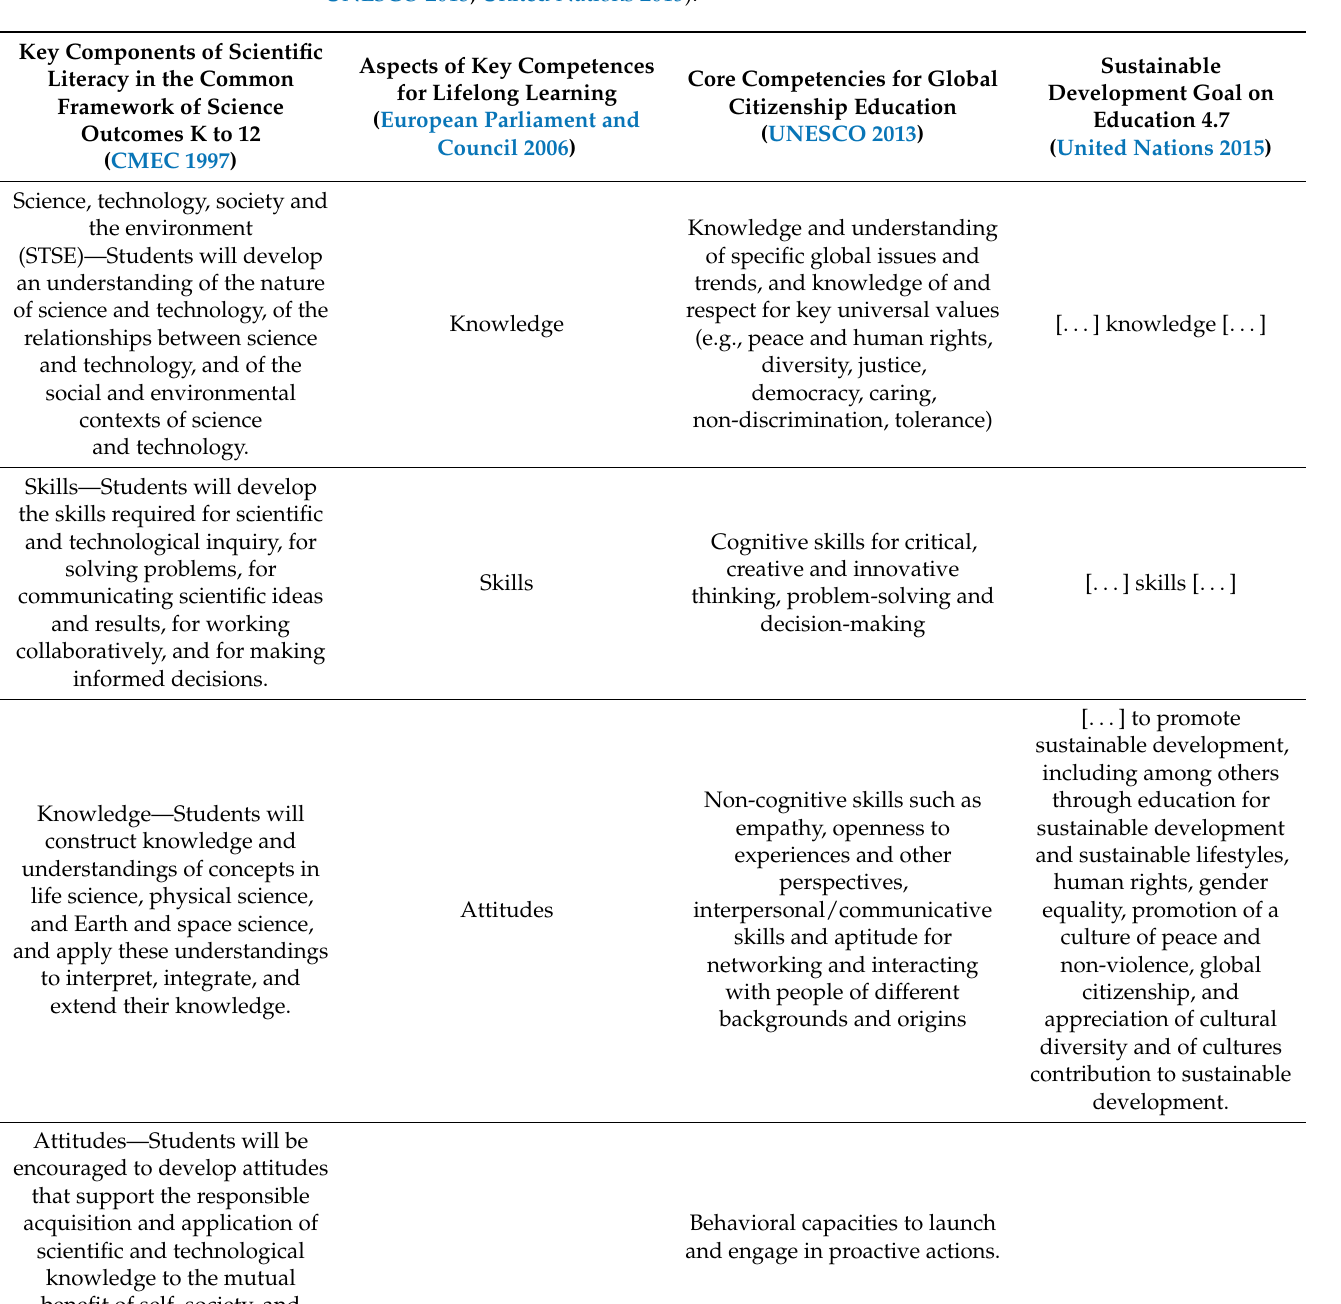
Table A1. Comparative overview of exemplary national and international curricular regulations for modern educational systems (sources from CMEC 1997; European Parliament and Council 2006; UNESCO 2013; United Nations